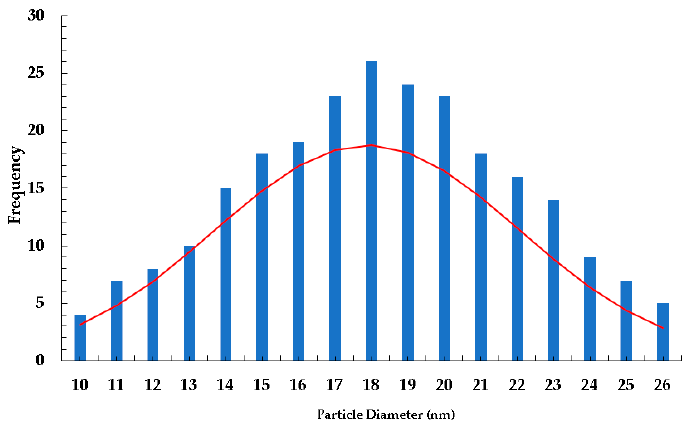
Figure 14. Histogram of particle sizes for the second batch with an average diameter of 17.9 nm.